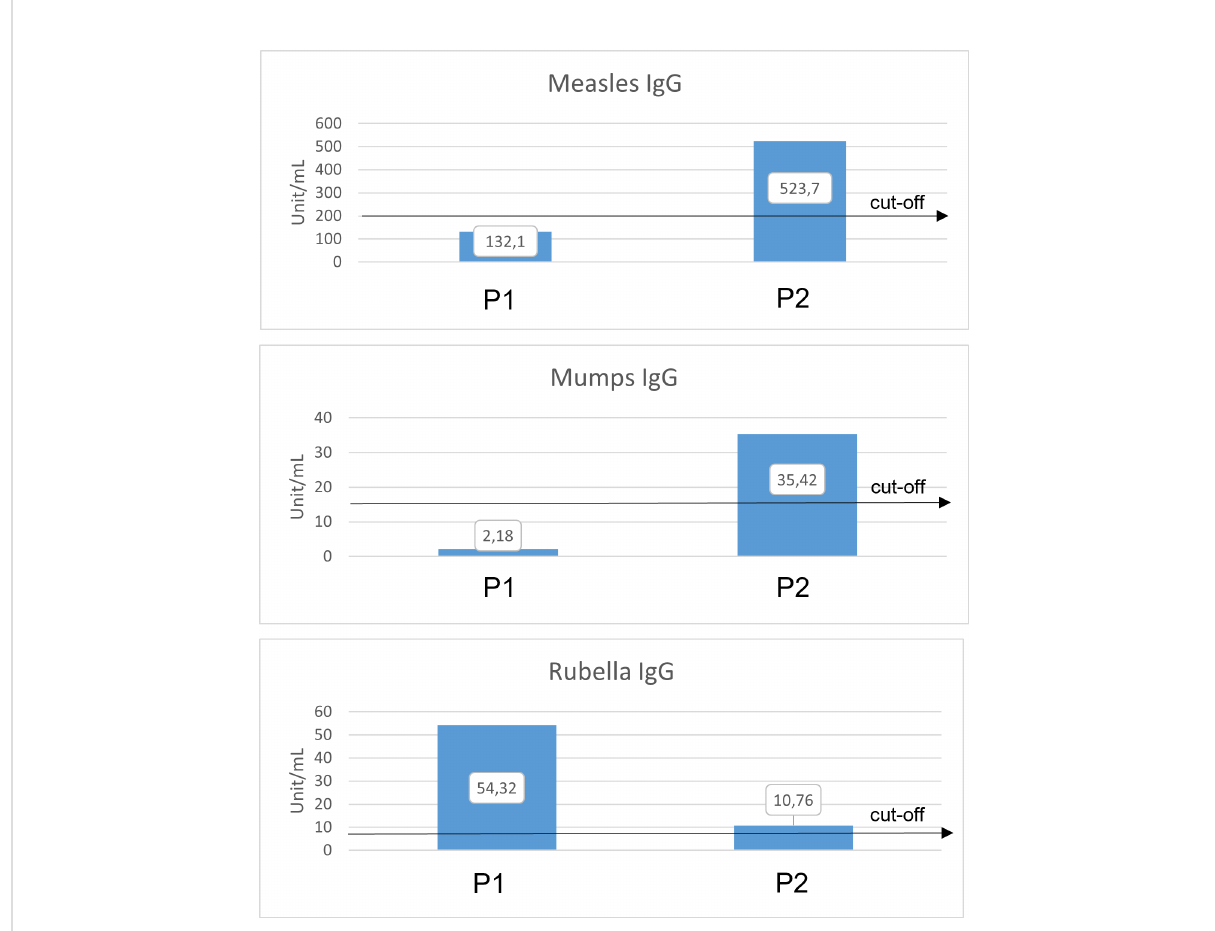
FIGURE 7 Anti-measles, anti-mumps, and anti-rubella antibody titers (Euroiummun, IgG) compared to the relative cutoff values. Anti-measles IgG cutoff = 200 U/ml. Anti-measles IgG P1 = 132.18 U/ml (negative), P2 = 523.77 U/ml (positive). Anti-mumps IgG cutoff = 16 U/ml. Anti-mumps IgG P1 = 2.18 U/ml (negative), P2 = 35.42 U/ml (positive). Anti-rubella IgG cutoff = 8 U/ml. Anti-rubella IgG P1 = 54.32 U/ml (positive), P2 = 10.76 U/ml (positive). Black arrows show cutoff